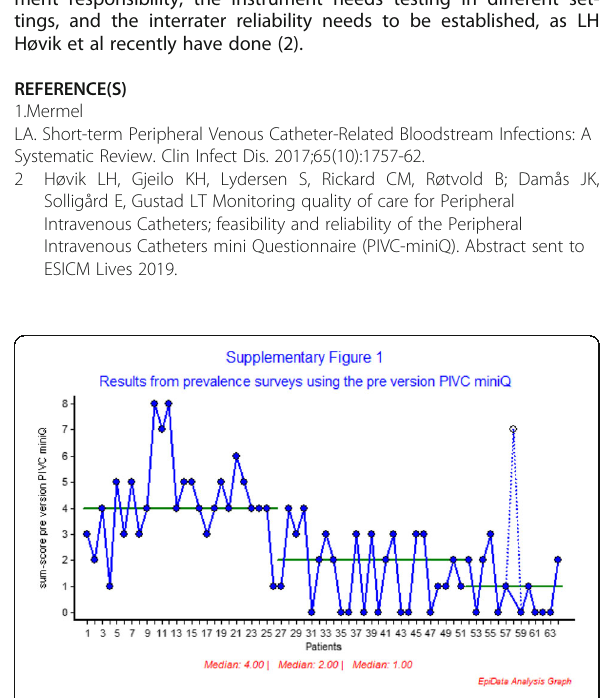
Fig. 1 (abstract 000808). Results from prevalence surveys using the pre version PIVC miniQ